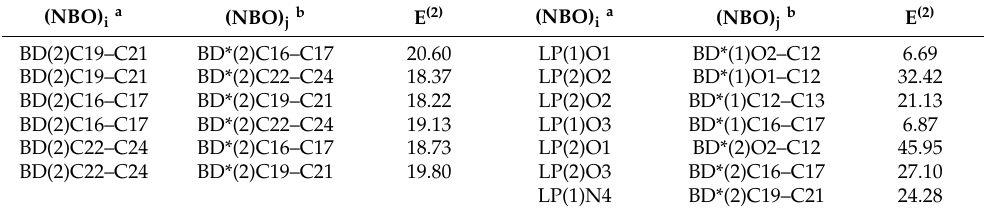
Table 4. NBO electron delocalizations in 4 .